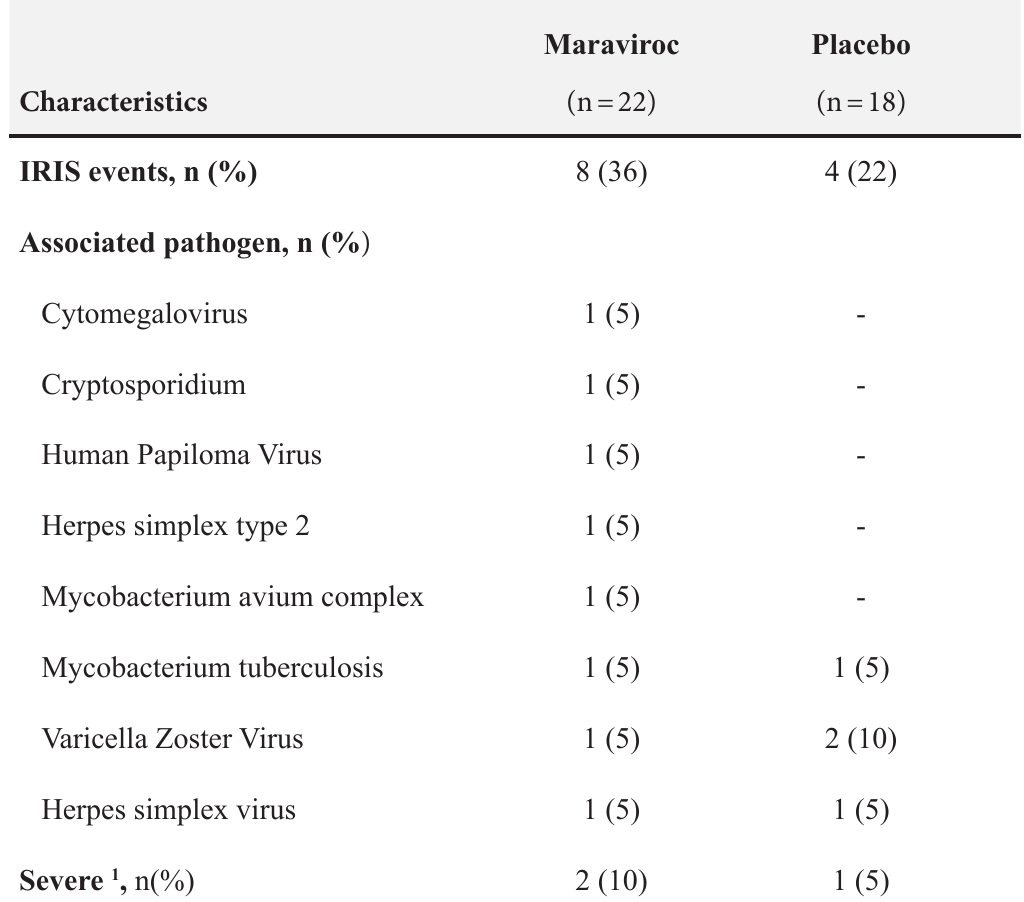
Table 3 . Immune Reconstitution Inflammatory Syndrome in trial substudy